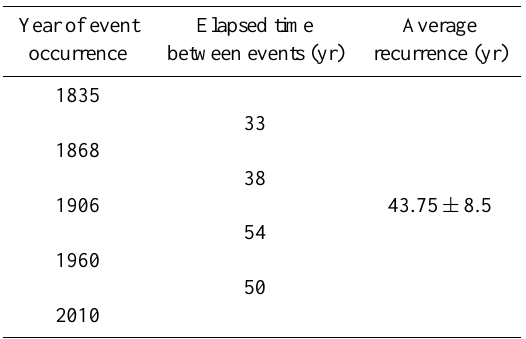
Table 2. The recurrence of the volcano-seismic events. In the first column the years of the five events deducible from the sufficiently complete part of the Smithsonian Institution database (see Figs. 1 and 2). The elapsed time between two consecutive events is shown in the central column. The average recurrence between two consec- utive events is 43.75yr, with a 68% probability of re-occurrence of the events ± 8 . 5yr, centered on the 43.75th year after the last recorded